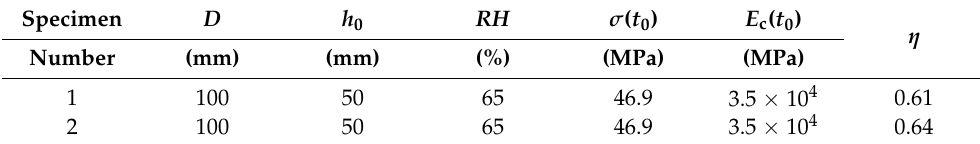
Table 4. Test parameters of cylinder components.